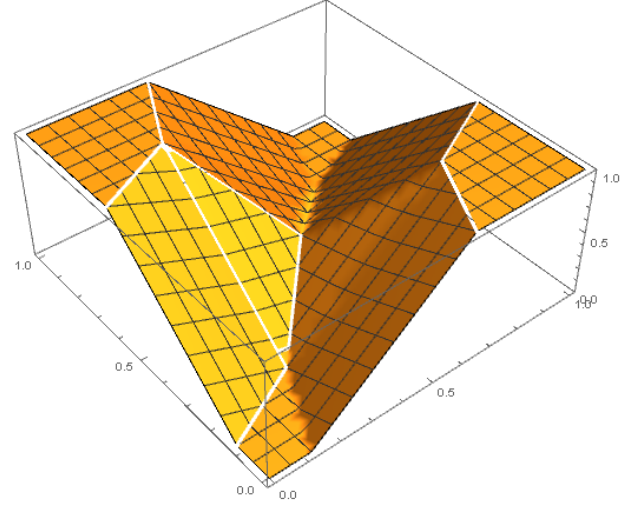
Figure 4. The graph of the function QD ( x , y ) given by Equation (14) for the parameters s = 1/3, p 1 = 1/4 and p 2 =